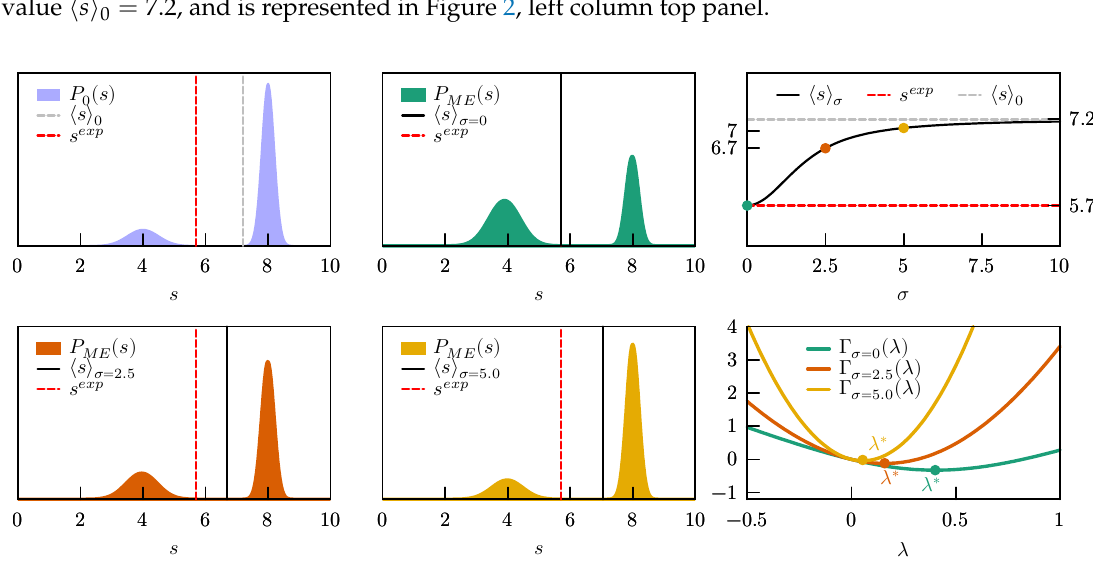
Figure 2. Effect of modeling error with a Gaussian probability distribution with different standard deviations σ on the posterior distribution P ME ( s ) . The experimental value is here set to s exp = 5.7, which is compatible with the prior distribution. Left and middle column: prior P 0 ( s ) and posterior P ME ( s ) with σ = 0, 2.5, 5.0. Right column: ensemble average (cid:104) s (cid:105) plotted as a function of σ and Γ ( λ ) plotted for different values of σ . λ ∗ denotes that value of λ that minimizes Γ ( λ )